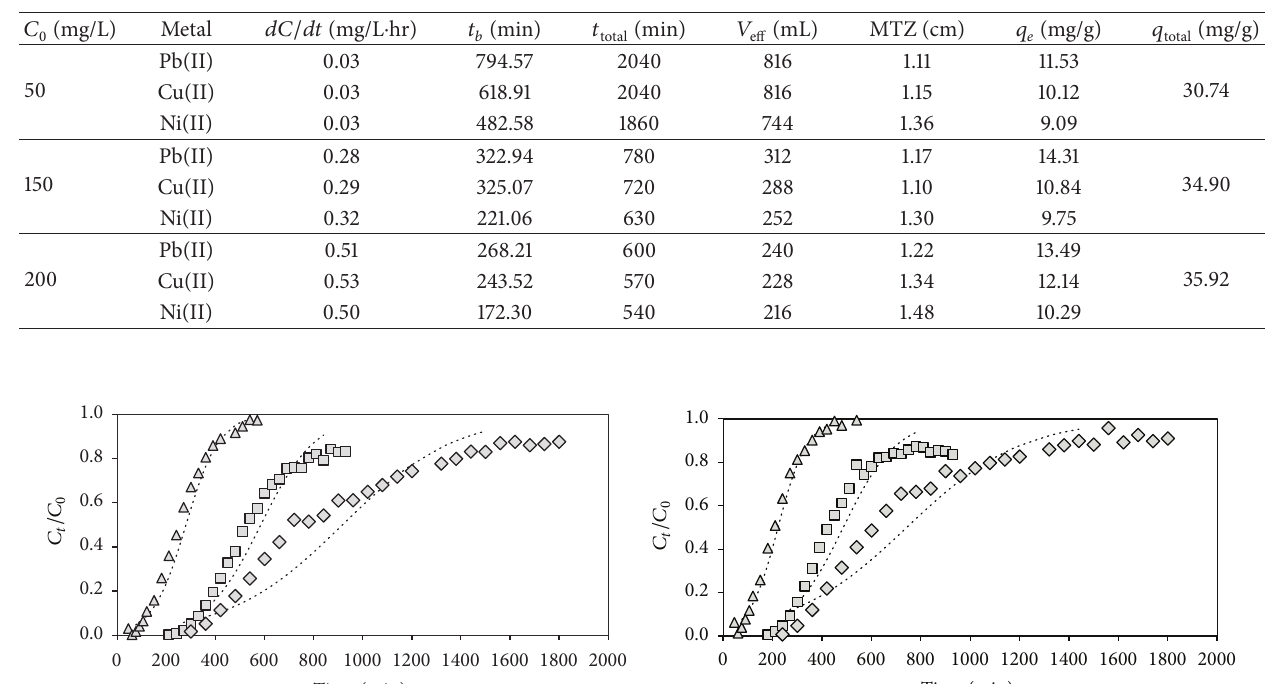
Table 4: Column adsorption data of ternary metal solution of Pb(II), Cu(II), and Ni(II) at different initial metal concentration with bed height of 2.0 cm and solution flow rate of 0.4 mL/min.